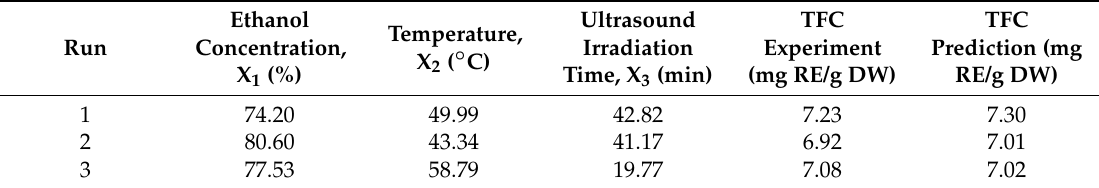
Table 3. Condition for the ramp function